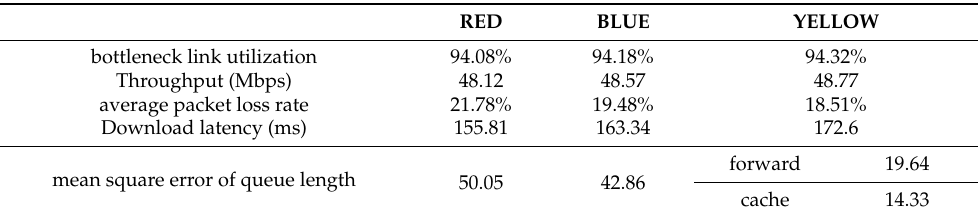
Table 6. Measurement data for heavy load network in time interval [20,